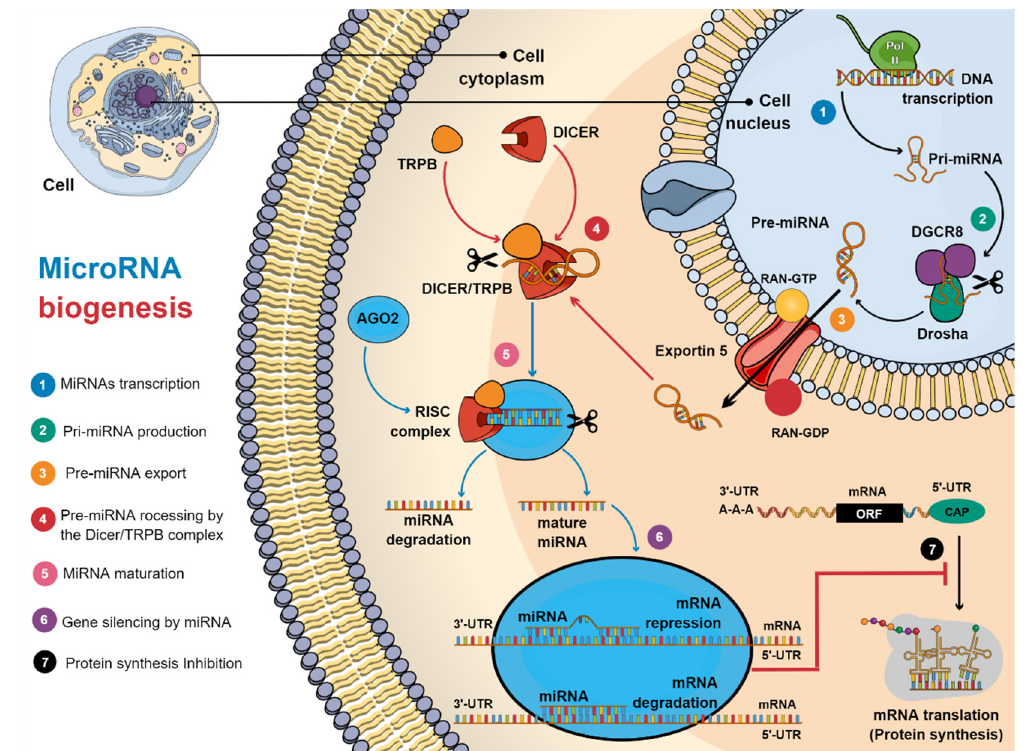
Figure 2. Biogenesis of miRNAs. (1) The transcription of miRNAs by RNA polymerase II (Pol II) produces the primary miRNA (pri-miRNA). (2) The Drosha/DGCR8 complex cuts the pri-miRNA, making the pre-miRNA. (3) Next, exportin-5 promotes nuclear translocation of the pre-miRNA. (4) Once the pre-miRNA has been translocated to the cytoplasm, it is processed by the Dicer/TRPB complex. (5) After cutting, a miRNA:miRNA* duplex is formed, which dissociates, causing the miRNA to mature. (6) Mature miRNA is incorporated into the RISC complex, to mediate gene silencing, either by repression (imperfect matching) or degradation (perfect matching) of target mRNA, inhibiting protein translation (7). Figure created in MindtheGraph by Muñoz-Carrillo et al., 2021.